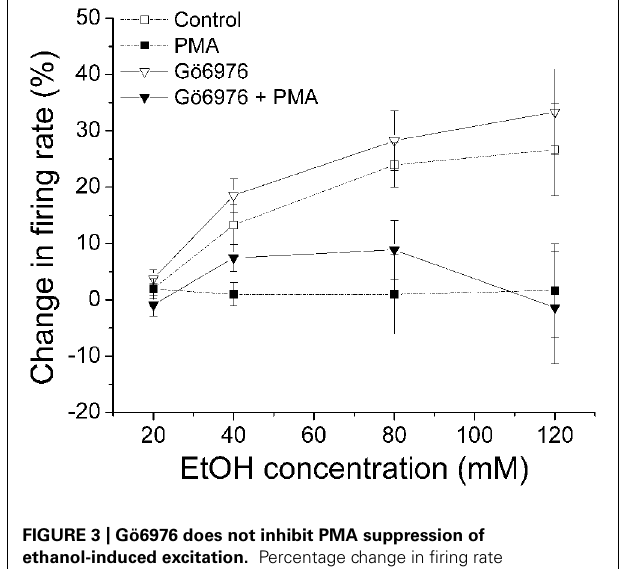
FIGURE 3 | Gö6976 does not inhibit PMA suppression of ethanol-induced excitation. Percentage change in firing rate (mean ± SEM) in response to ethanol application in different conditions is plotted as a function of time.The effect of ethanol alone ( (cid:2) ), and ethanol in the presence of PMA ( (cid:3) ) from Figure 1C are shown for comparison. In the presence of Gö6976 (10 μ M) and PMA (1 μ M) in the recording pipette, ethanol did not cause a significant increase in firing rate at all concentrations ( (cid:4) , n = 5; one-way repeated measures ANOVA, F ( 3,21 ) = 0.92, p > 0.05). With Gö6976 (10 μ M) in the recording pipette, a significant increase in firing rate produced by increased concentrations of ethanol was observed ( ∇ , n = 11; one-way repeated measures ANOVA, F ( 3,12 ) = 8.03, p < 0.05).